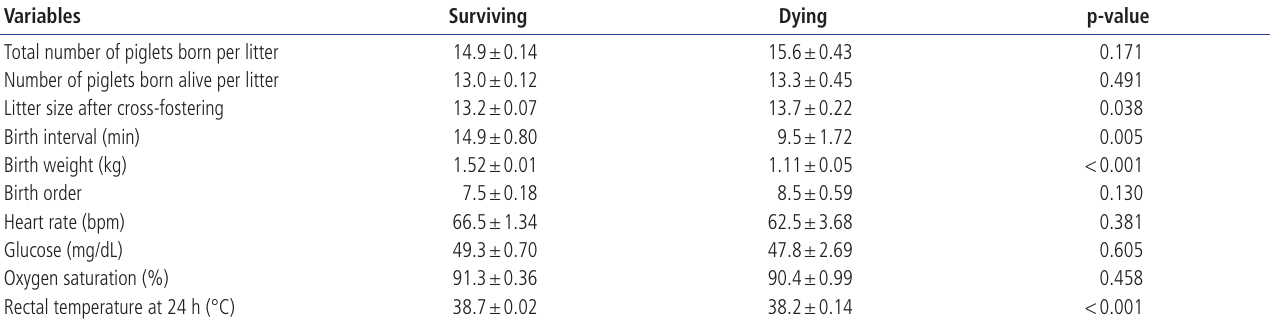
Table 2. Potential indicators for piglet pre-weaning mortality (means±standard error of the mean) comparing surviving piglets from birth to day 7 of lactation (n = 631) with dying piglets (n = 59) Variables Total number of piglets born per litter